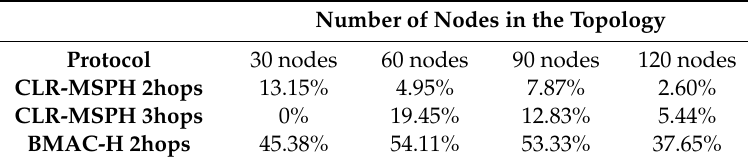
Table 6. Scalability and handover packets in each protocol.